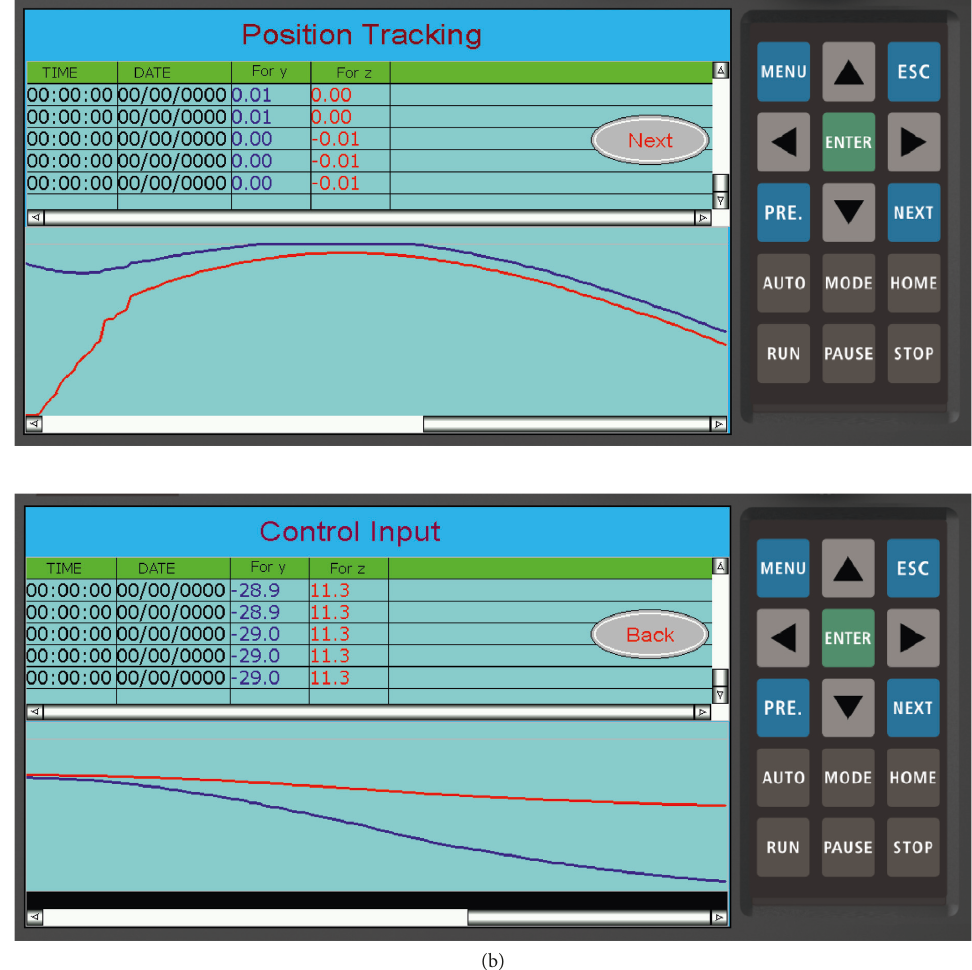
F IGURE 7: (a) The experimental planning and platform. (b) The experimental results displayed in human-computer interaction platform including position tracking signals for both y and z and corresponding control